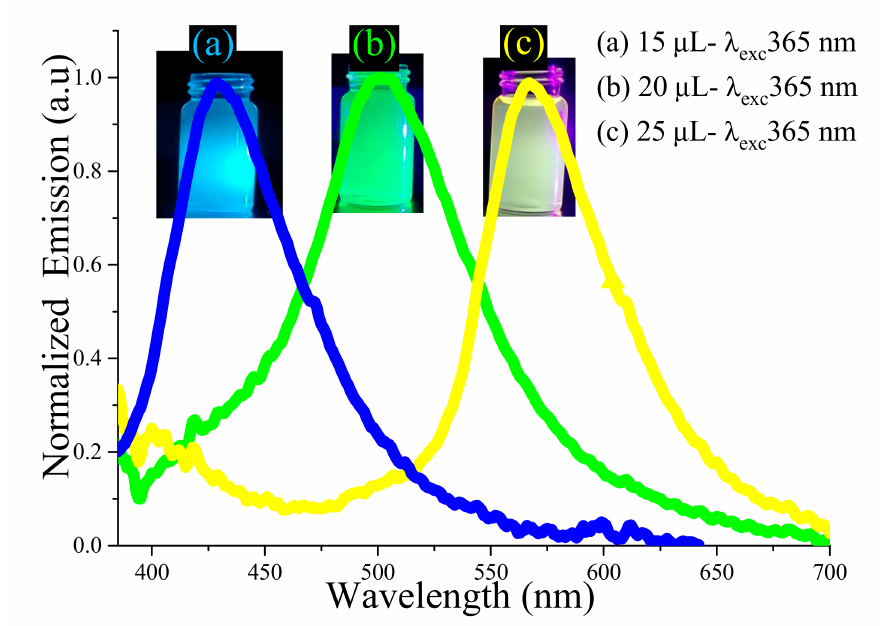
Figure 11. PL spectra (excited at 365 nm) of the colloidal ZnSiQDs synthesized with NH 4 OH of ( a ) 15 µ L, ( b ) 20 µ L, and ( c ) 25 µ